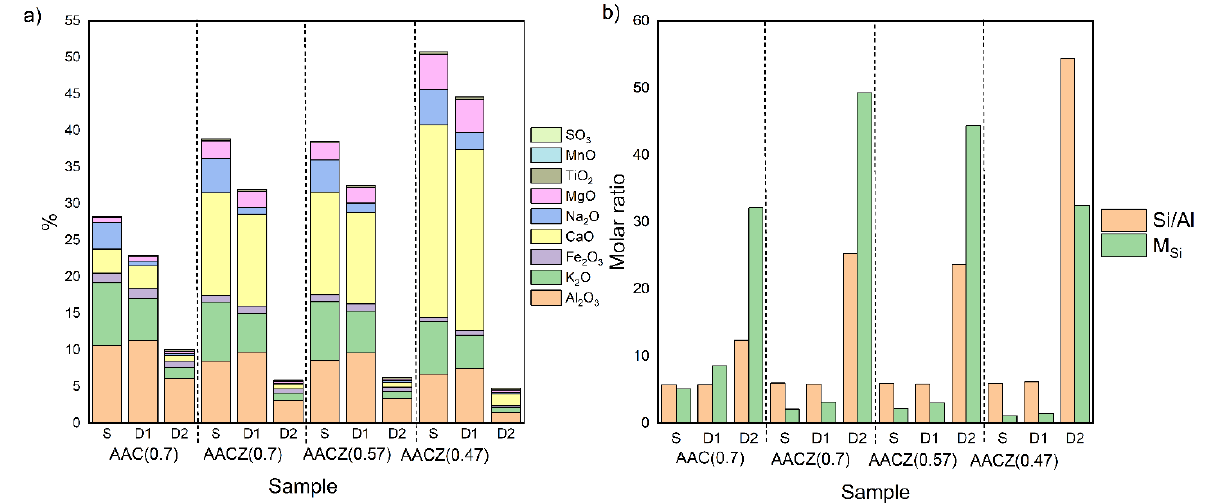
Figure 2. Chemical composition of samples (Si is up to 100%) ( a ) and Si/Al molar ratio and M Si parameter ( b ) of variously prepared unmodified S samples, modified D1 and D2 samples leached 0.1 M HCl and 3 M HCl, respectively. Determination by XRF.